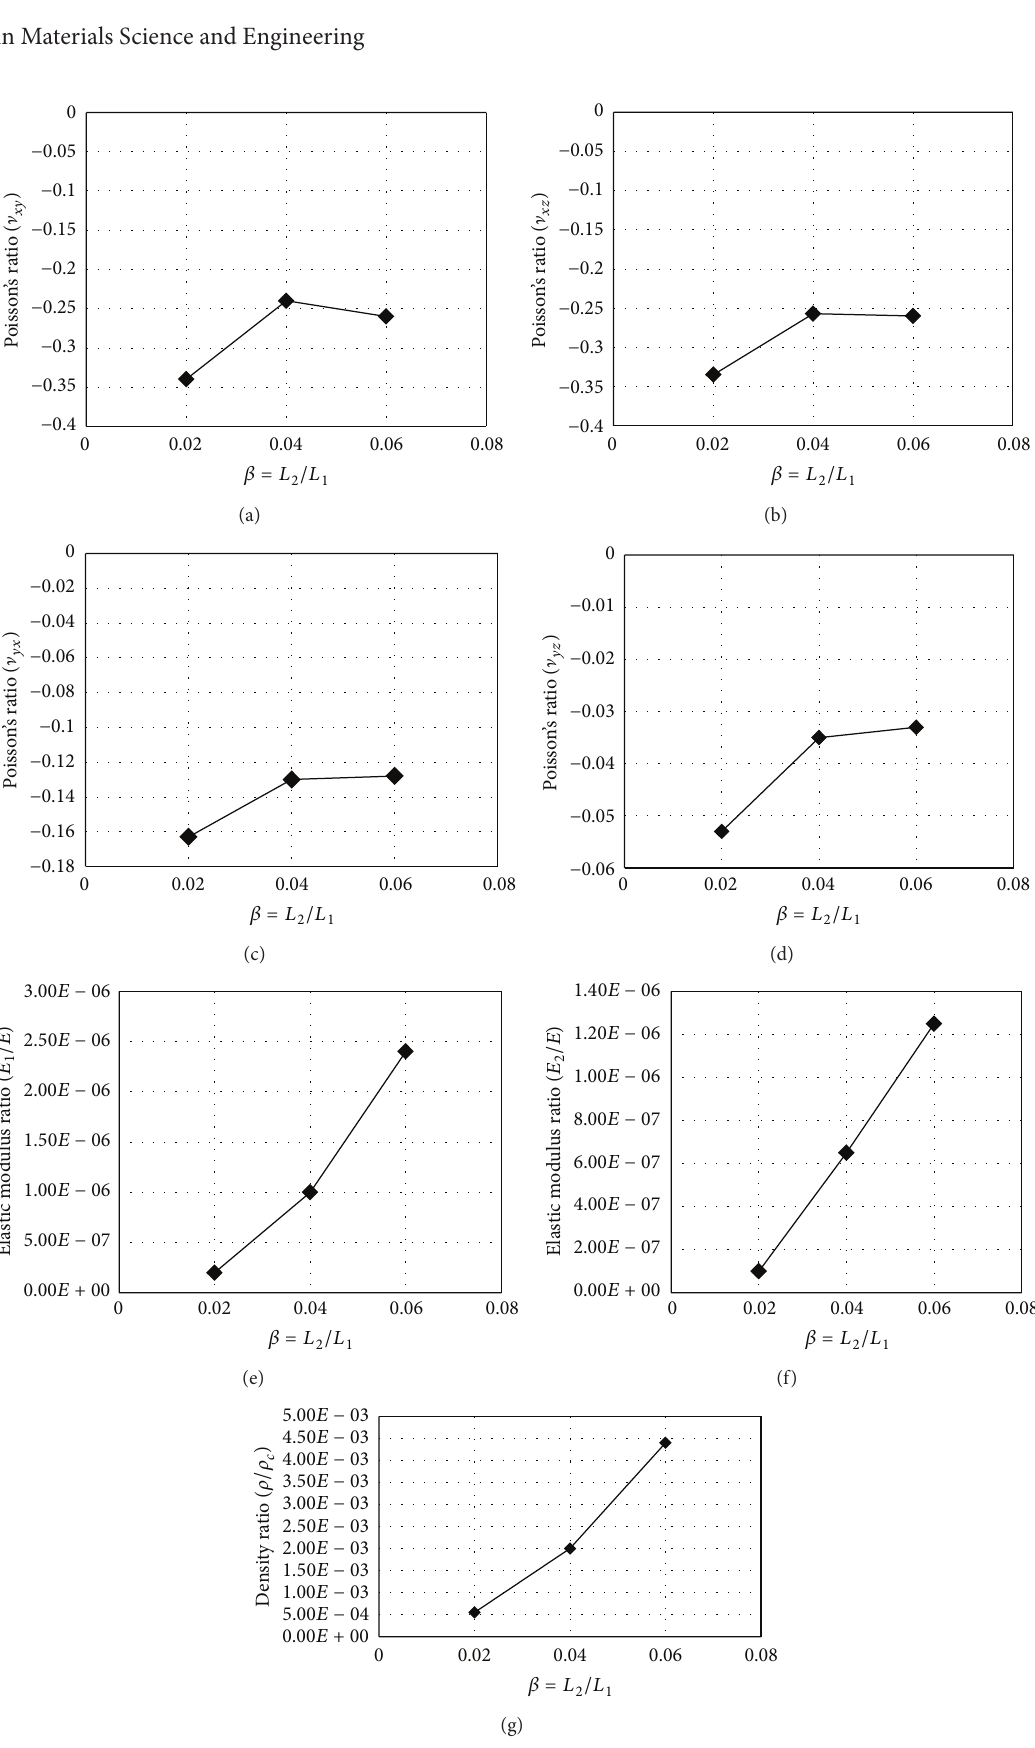
Figure 5: Mechanical properties versus 𝛽 in the case of fixing 𝜃 and 𝛾 at 60 ∘ and 0.02,